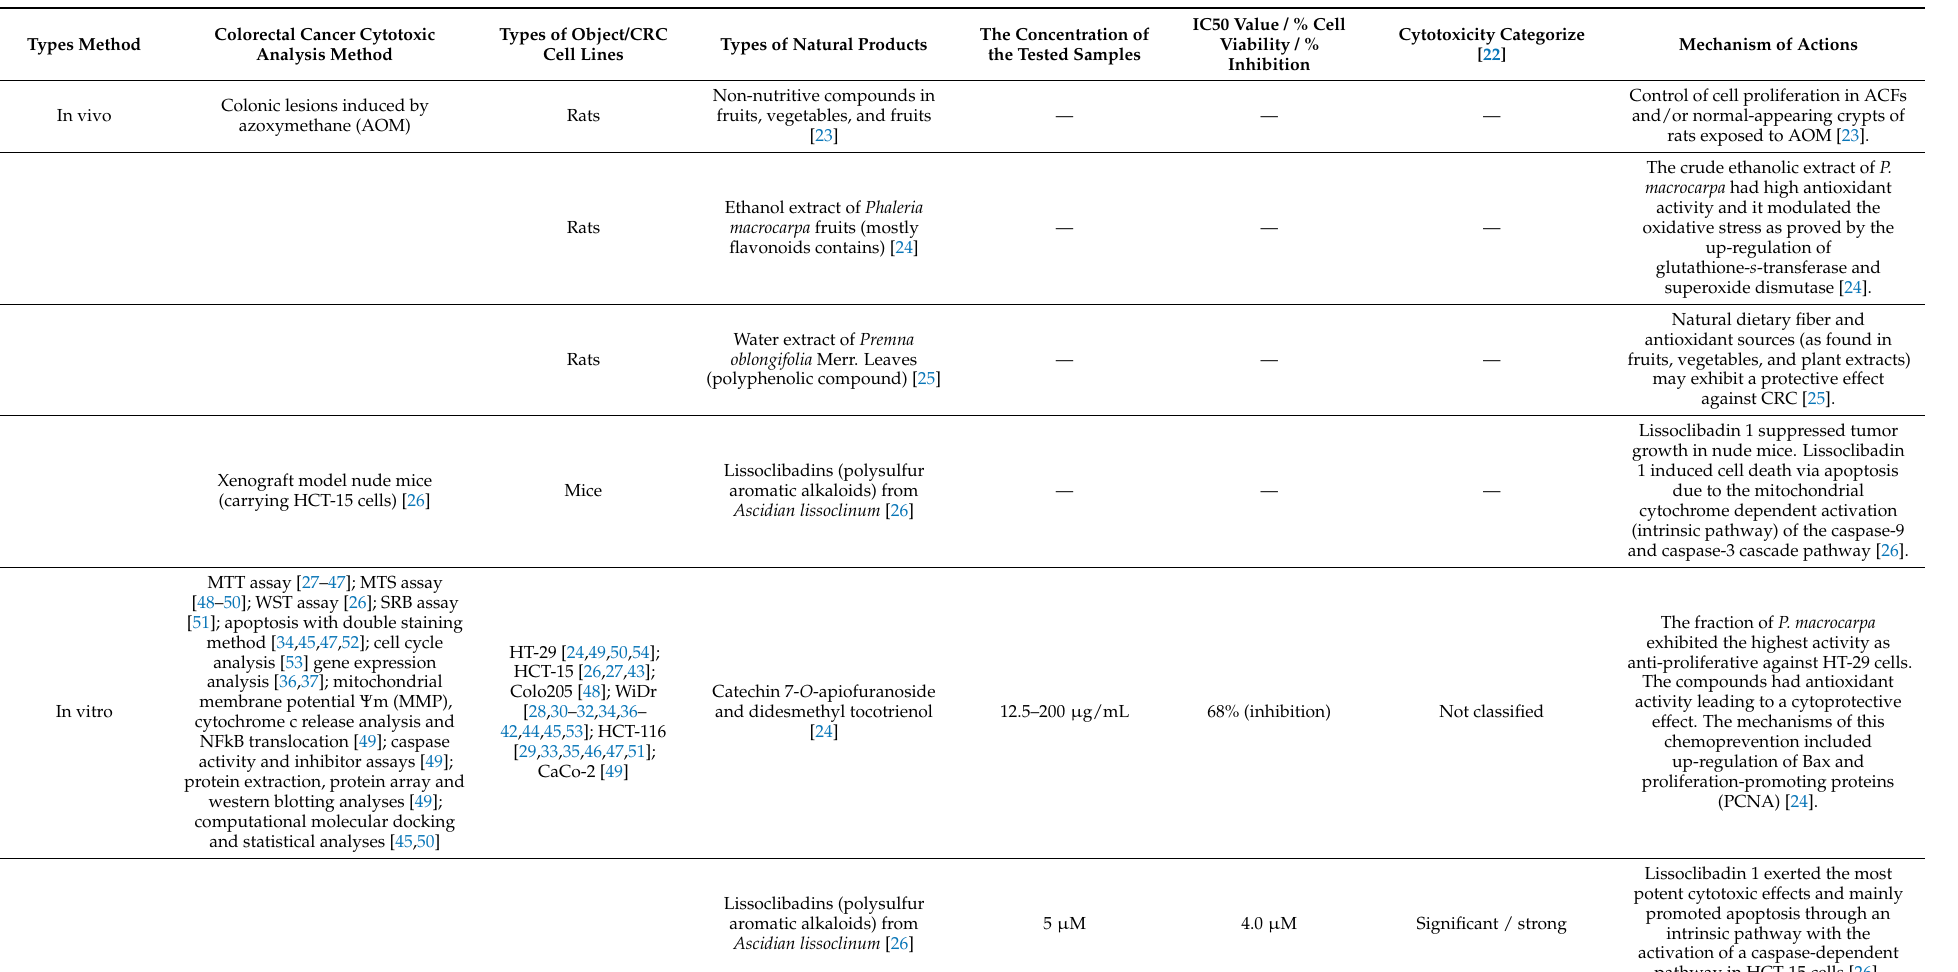
Table 6. Systematic review results summarized from 38